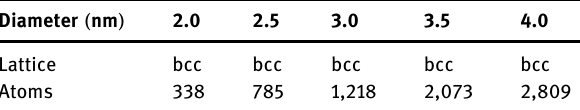
Table 4: FNP models for melting